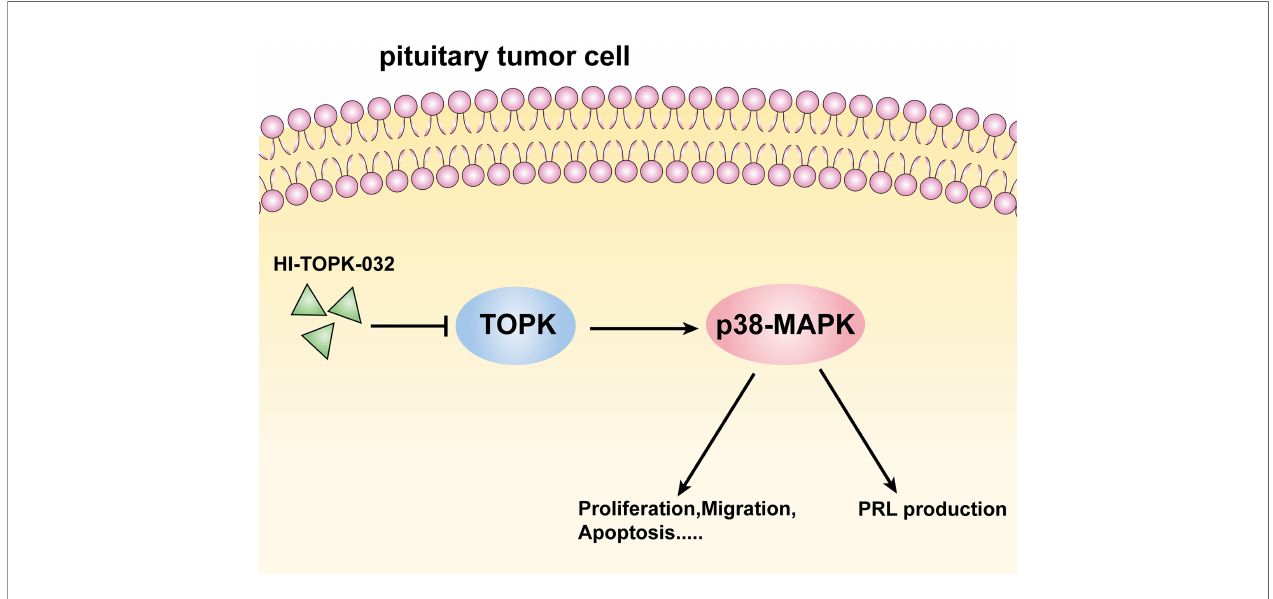
FIGURE 6 | Schematic diagram of regulation